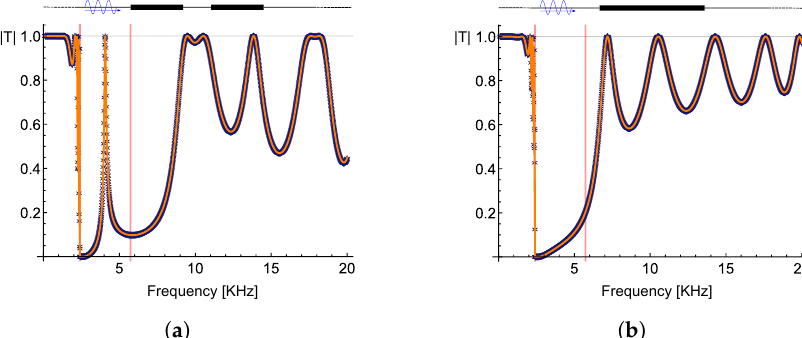
Figure 7. Transmission coefficient modulus | T | as a function of the frequency ω in presence of the cavity ( a ) and without any cavity ( b ). The vertical red lines define the band gap. Orange: analytic results and blue: numerical results of analyses in the frequency domain, considering a sweep of frequencies from 0 to 20